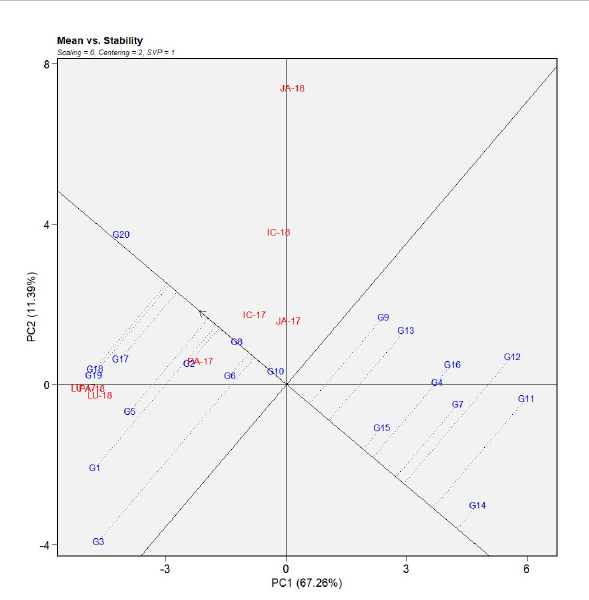
FIGURE 2 Mean vs. stability view of GGE biplot of IABN against AB severity across four locations during 2 years. The data were centered through environments (centering = 2) without scaling (scaling = 0). Locations are denoted as IC- (ICRISAT), JA- (Jammu), LU- (Ludhiana), and PA- (Palampur). Years are denoted as -17 (year 2017/ 2018) and -18 (year 2018/2019). IABN, International Ascochyta Blight Nursery; AB, Ascochyta blight.